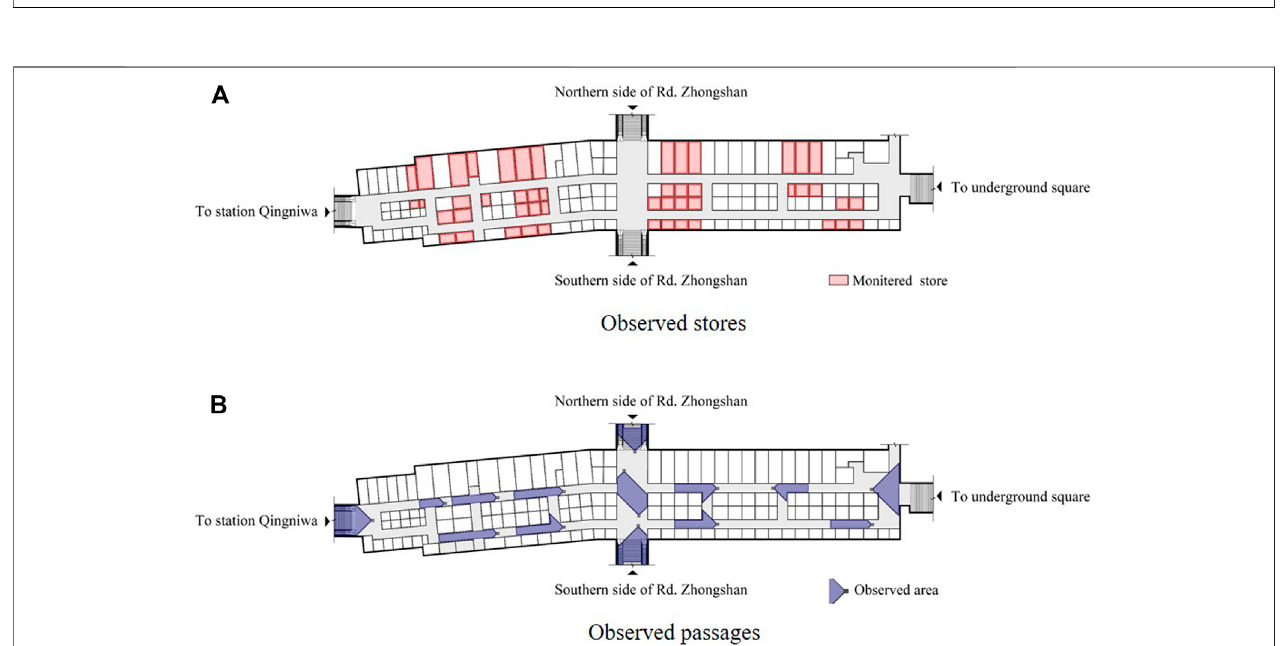
FIGURE 2 | Study area and data collection area: (A) observed stores; (B) observed passages.